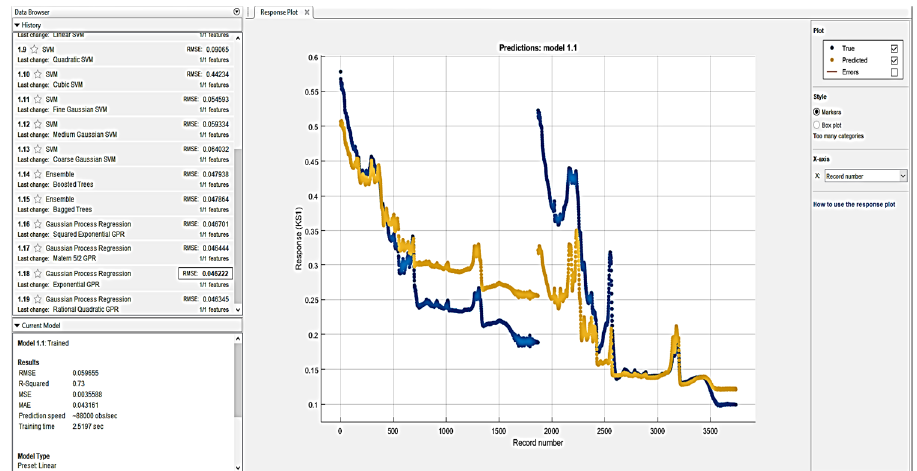
Figure 8. Regression learner environment—a prediction model [authors own processing].